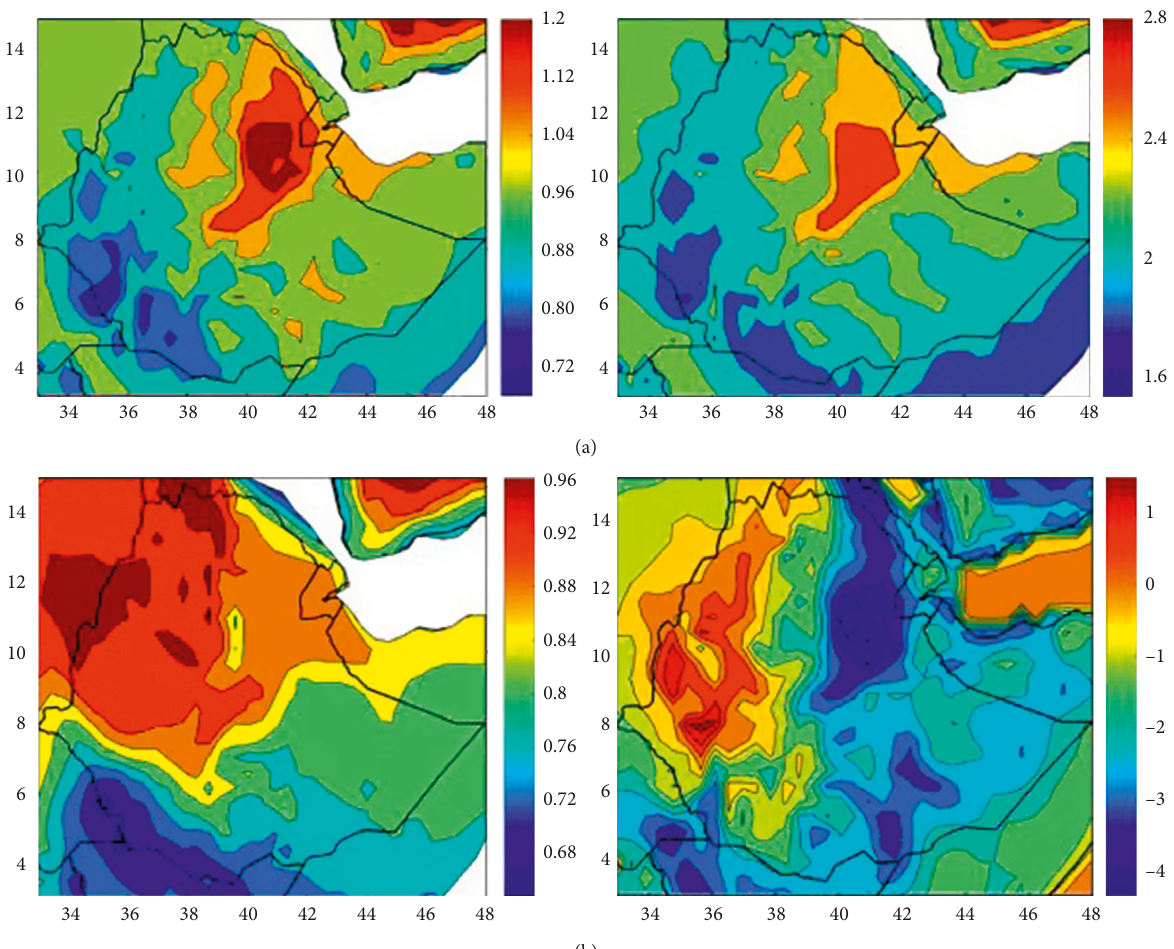
Figure 12: Contour-based spatial variability of extremes of TMINmean under RCP4.5 and RCP8.5 scenarios (a) and TMAXmean under RCP4.5 and DTR RCP8.5 scenarios